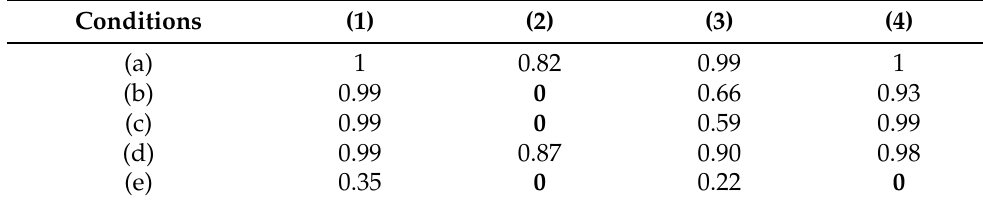
Table 2. Statistical test: Packet length ( p -value).